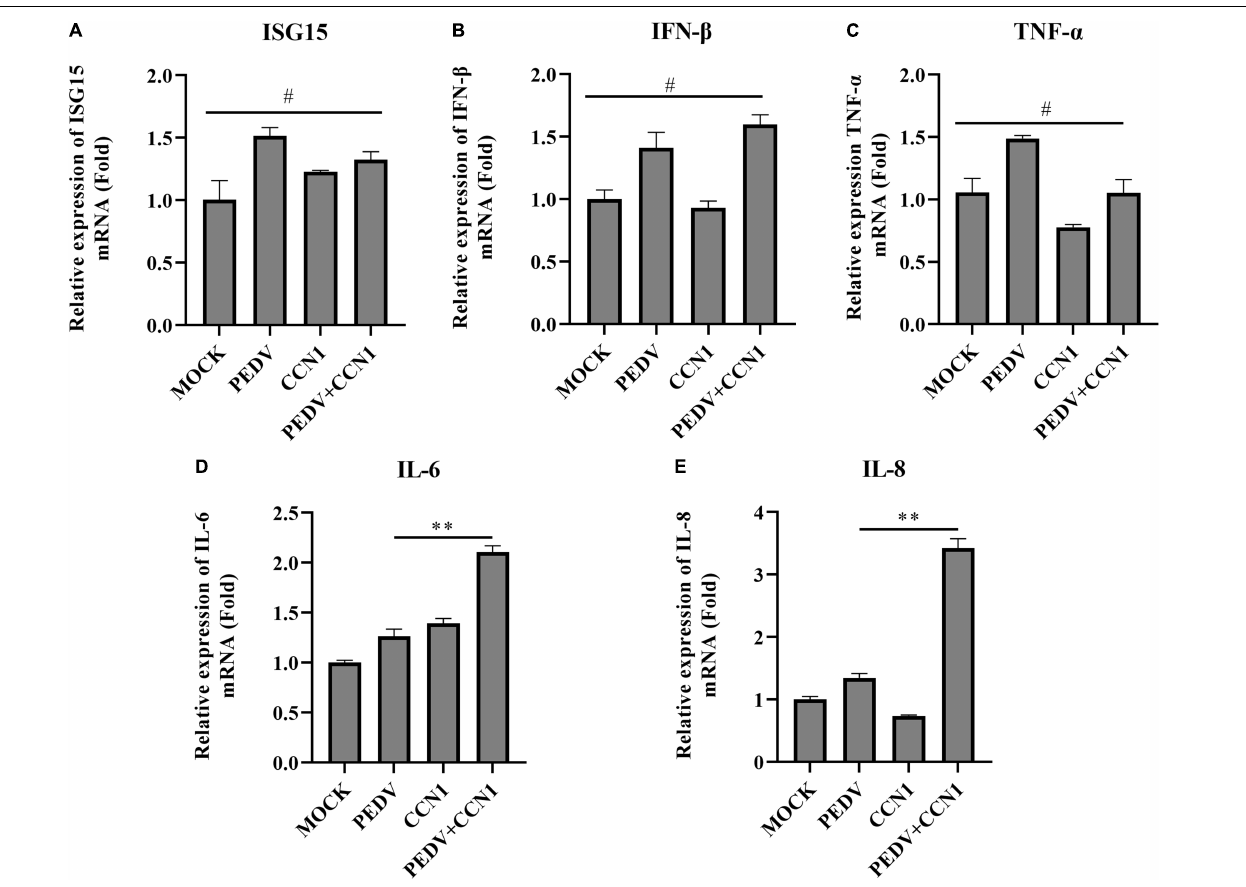
FIGURE 6 | Cell communication network factor 1 has no effect on the expression of interferon. (A–E) Marc-145 cells were transfected with pcDNA3.1-CCN1-his or pcDNA3.1-his vector for 36 h and were infected with or without the PEDV strain. At 24 h, cells were collected to analyze the mRNA level of ISG15 (A) , IFN- β (B) , TNF- α (C) , IL-6 (D) , and IL-8 (E) by real-time PCR assay. The data were performed from three independent experiments. The differences were evaluated using Student’s t -test, and significance differences were denoted by ∗∗ p <